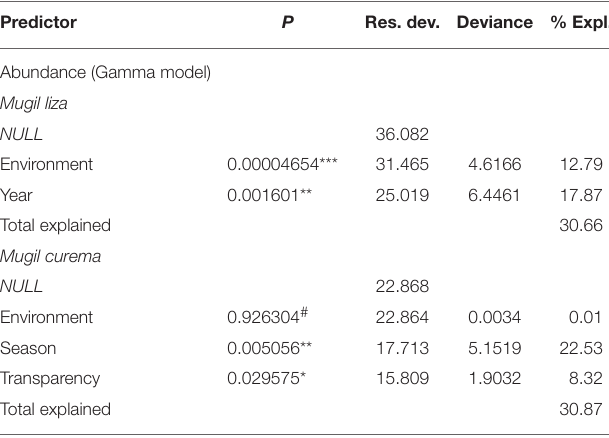
Values of significance (P) for each factor, residual deviance (Res. Dev.), deviance and percentage of the total deviance explained by each factor (%Expl.) are